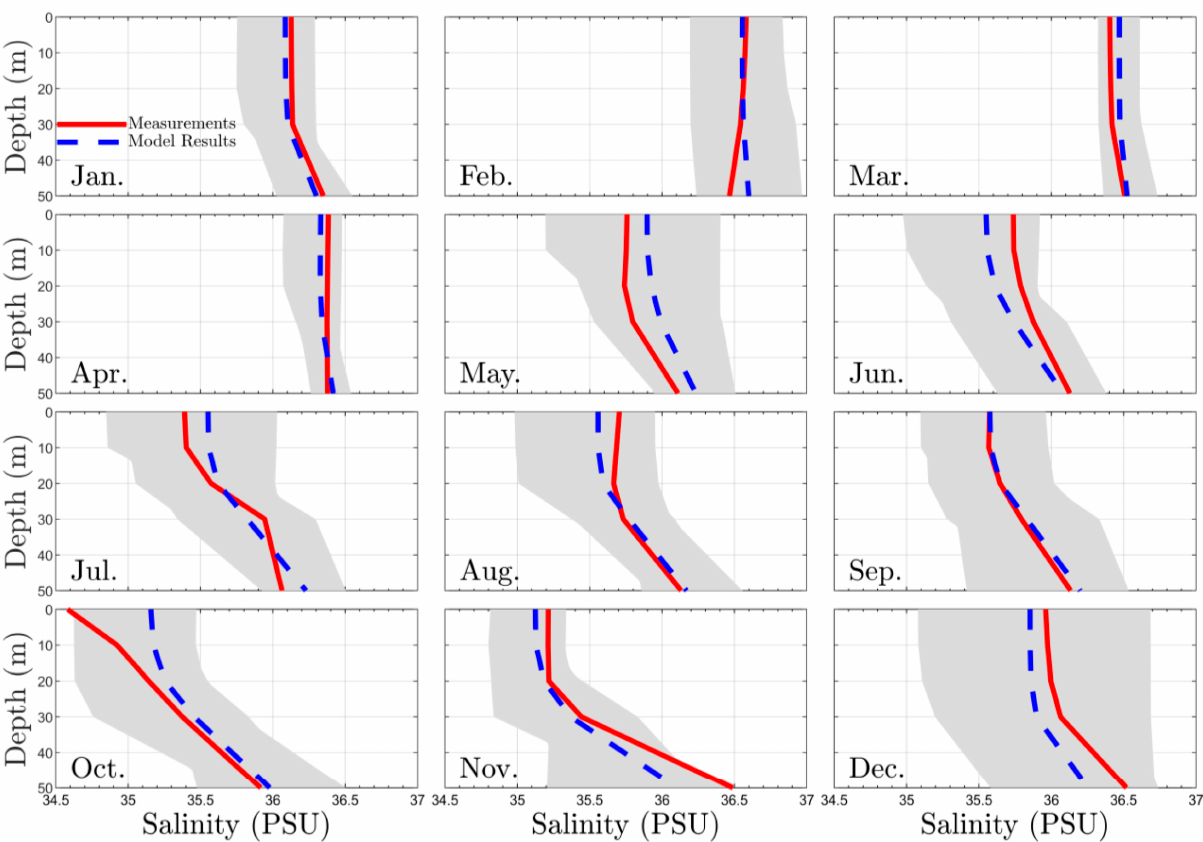
Figure 9. Comparison of measured (red line) and simulated (dashed blue line) salinity profiles and model results for each month (shaded area). Salinity ranges by month (max–min): Jan. (36.55–35.75